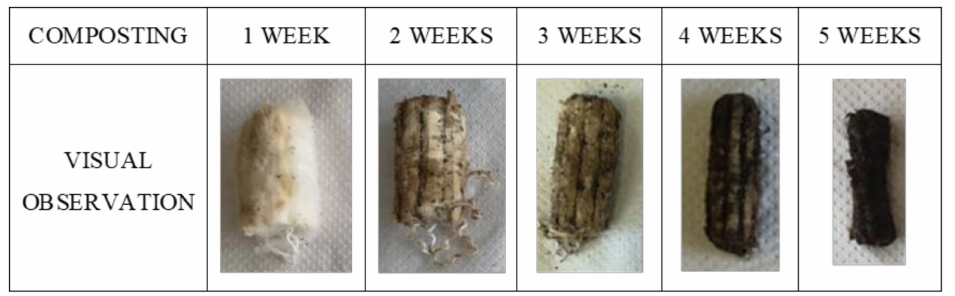
Figure 7. Cotton tampons functionalized using CBD liposome liquid formulation after soil burial test, visual observation after 1–5